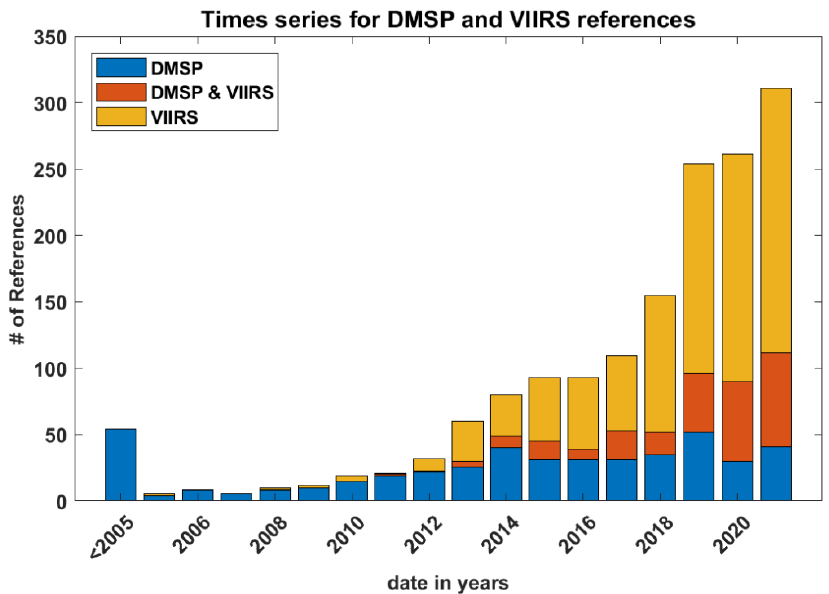
Figure 21. Time series of publication dates for number of references according to sensor.